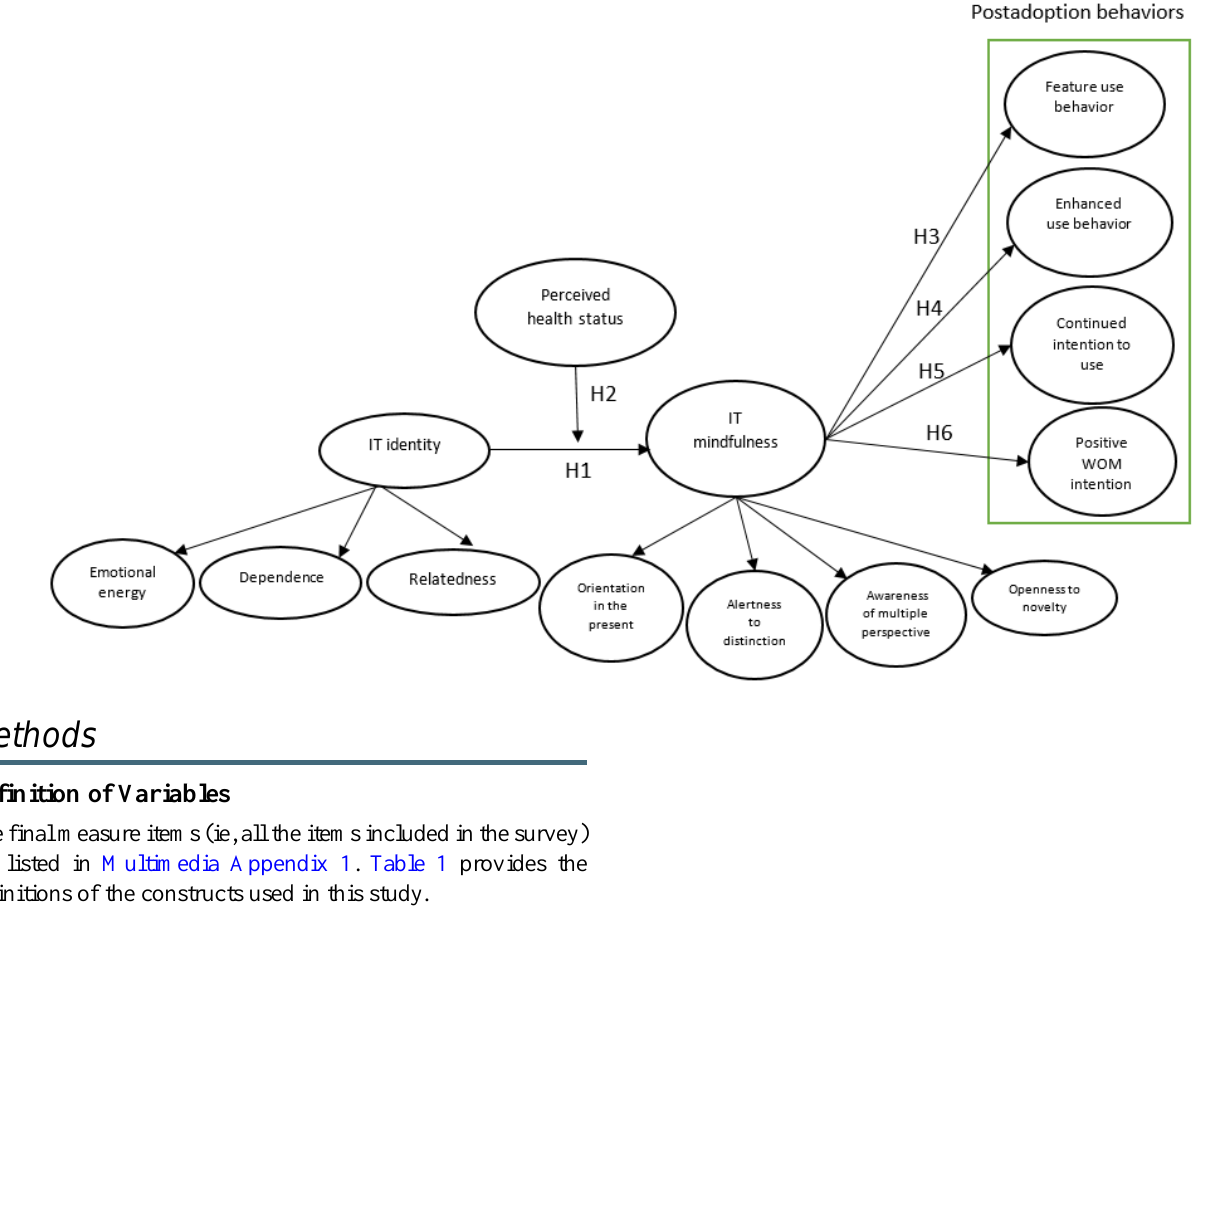
Figure 1. Research model. IT: information technology; WOM: